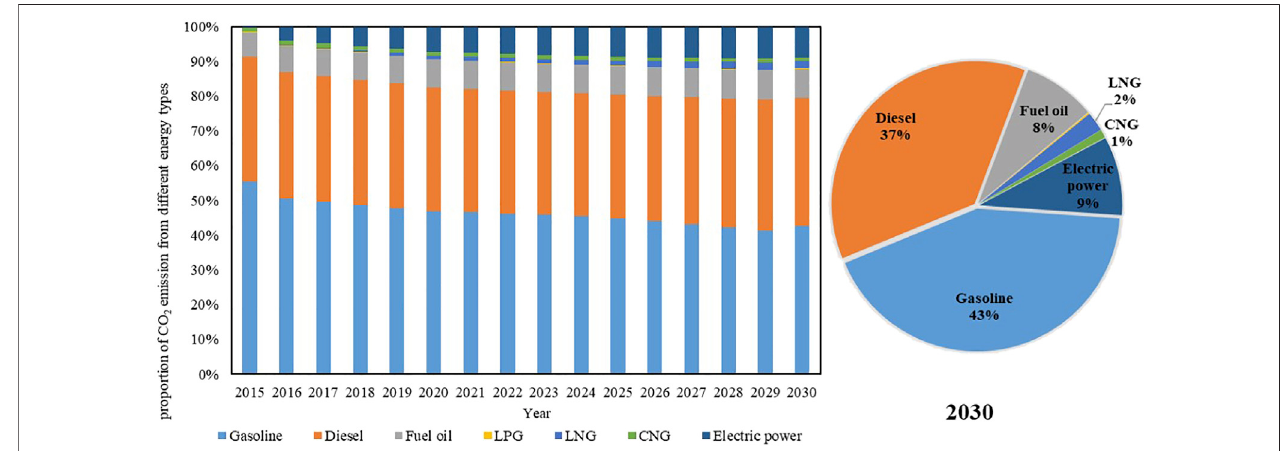
FIGURE 7 | Prediction of CO 2 emission of energy sources of transportation under the low-carbon scenario in Guangdong Province.